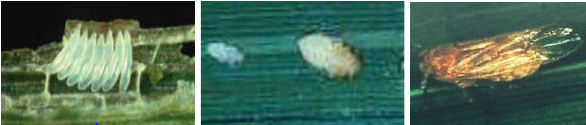
Figure 1. Eggs, nymphs and adult BPHs